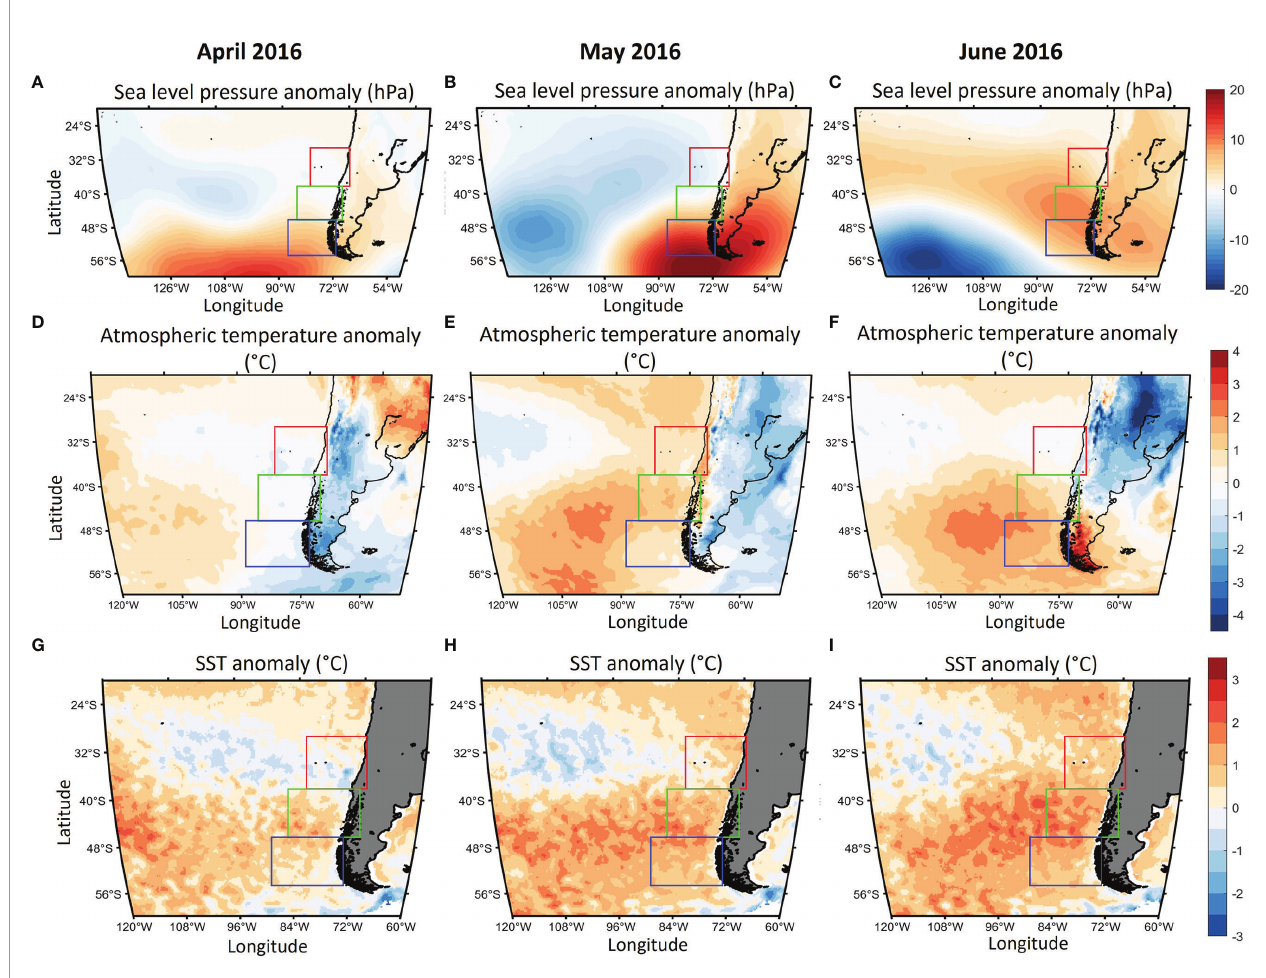
FIGURE 6 | Monthly average sea level atmospheric pressure anomalies (A – C) , atmospheric temperature anomalies (D – F) and sea surface temperature (SST) anomalies (G – I) , expressed respectively in hPa, °C and °C, for the months of April 2016 (left column), May 2016 (central column) and June 2016 (right column). Colour scale is indicated on the right side of each line. Areas concerned are all located between 20°S and 50°S, and between 50°W and 140°W for pressure anomaly, between 60°W and 120°W for air temperature anomalies and between 60°W and 120°W for SST